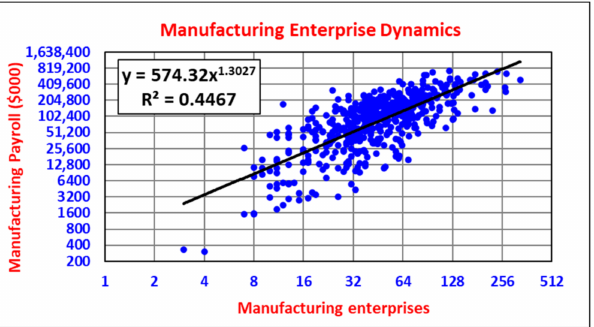
Figure 6. The power-law association between the number of manufacturing enterprises and manu- facturing payrolls in United States